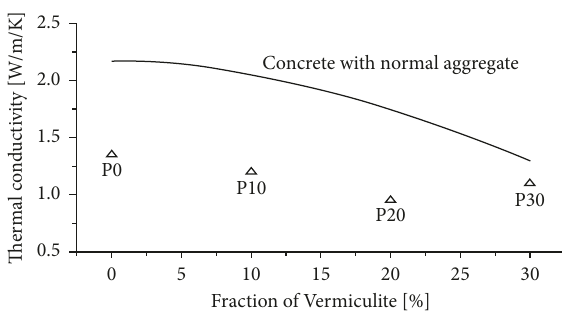
Figure 6: Thermal conductivity of concrete with pumice aggre- gates. Increase in vermiculite by 20% caused a 30% decrease in thermal conductivity, k